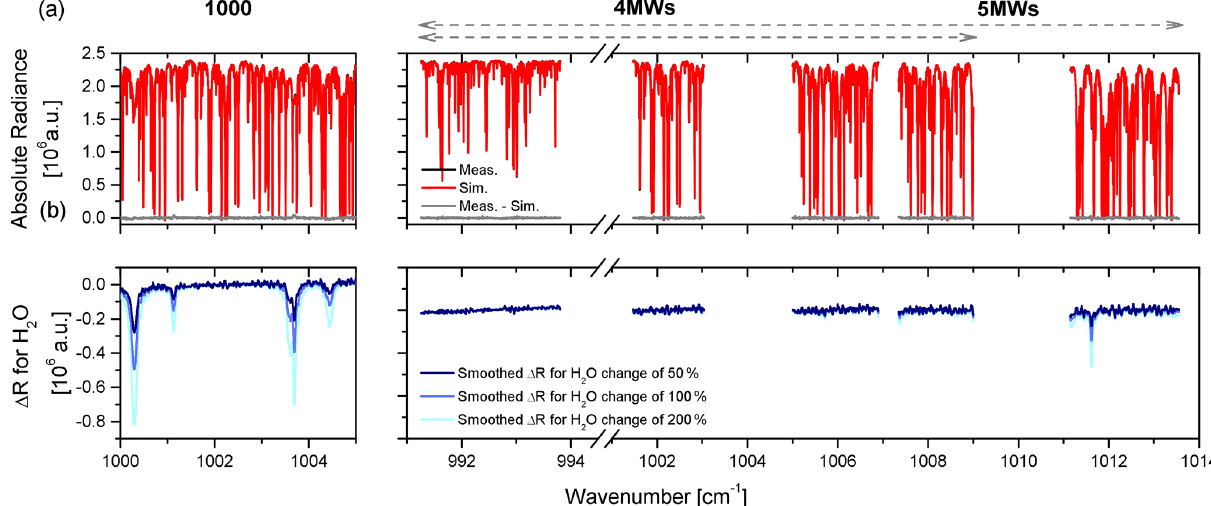
Figure 2. (a) Spectral regions considered in the different FTIR O 3 retrieval strategies: the broad window used in the setups 1000 and 1000T (encompassing the 1000–1005cm − 1 spectral region) and the four and five micro-windows used in the setups 4MWs/4MWsT (between ∼ 991 and 1009cm − 1 ) and 5MWs/5MWsT (between ∼ 991 and 1014cm − 1 ), respectively. Red and black lines depict, respectively, examples of the simulated and measured spectra taken on 31 August 2007 (at a solar zenith angle (SZA) of ≈ 50 ◦ , an O 3 amount in the slant column (O 3 SC) of 390DU, and an H 2 O TC of 10.7mm). Grey lines show the difference between the measurement and simulation. (b) Spectral changes in the measured FTIR radiances ( (cid:49)R ) due to changes in the H 2 O content of 50% (TC of 16.1mm), 100% (TC of 21.5mm), and 200% (TC of